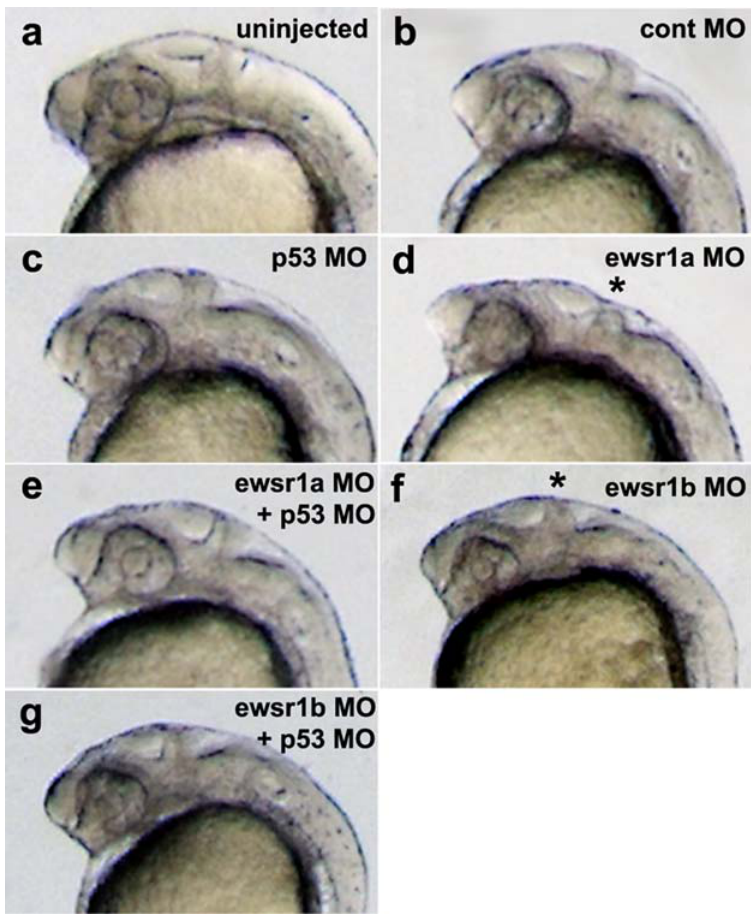
Figure 5. MO Knockdown of p53 Rescues Morphologic Abnormalities in ewsr1 Knockdown Embryos. Lateral views of (a) uninjected, (b) control MO, (c) control MO and p53 MO, (d) ewsr1a MO, (d) ewsr1a MO + p53 MO injected embryo, (e) ewsr1b MO and (f) ewsr1b MO + p53 MO injected embryo at 24hpf. Asterisk (*) indicates the normal MHB structure (d and f).